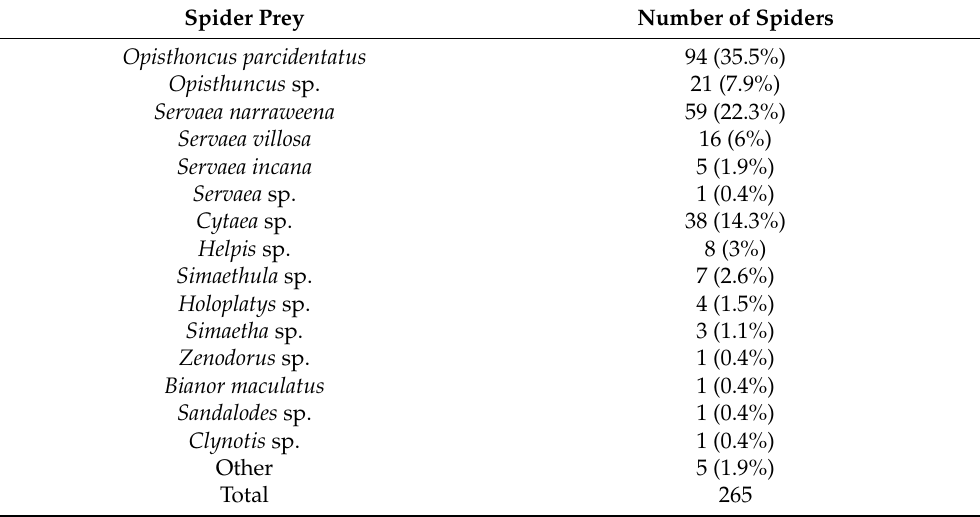
Table 2. Identification of 265 salticid spiders collected from mud nests of Sceliphron formosum , including at least 11 genera and 15 species of